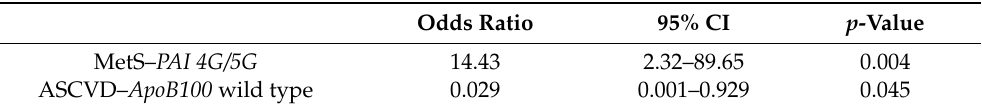
Table 8. Multivariate regression analysis to predict relationship of PAI1 and ApoB gene polymorphism with MetS and ASCVD,